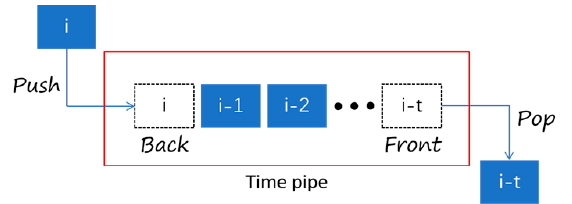
Figure 4. The handing of the time stream. The index i, i − 1…, i − t in the square indicates the image sequence.